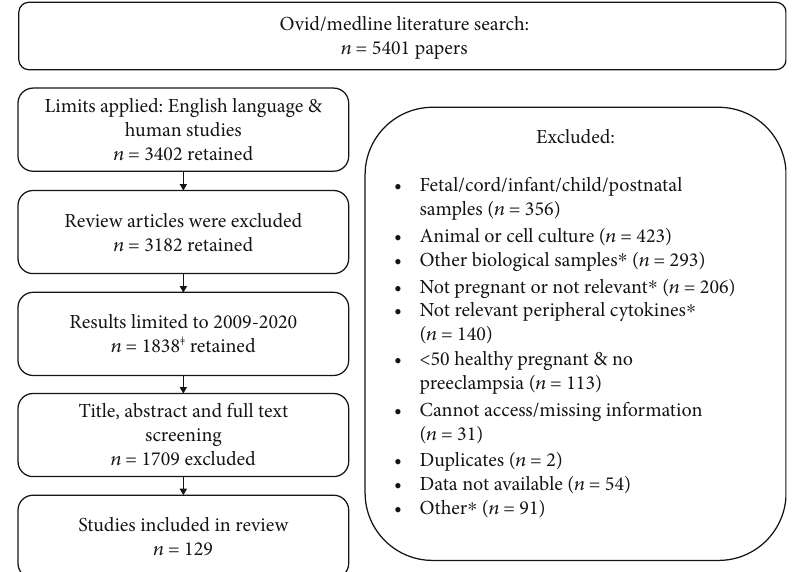
Figure 1: Summary of the literature search and papers retained or excluded. ⱡ Including four additional papers identi fi ed from references. ∗ Other biological samples: e.g., plasma, whole blood, CSF, and PBMCs; not pregnant or not relevant: e.g., IVF, recurrent miscarriage, fertile and infertile women, and infection or periodontitis/gingivitis; not relevant peripheral cytokines: e.g., gene polymorphisms or expression; other included not healthy pregnancy or preeclampsia and adolescent or twin